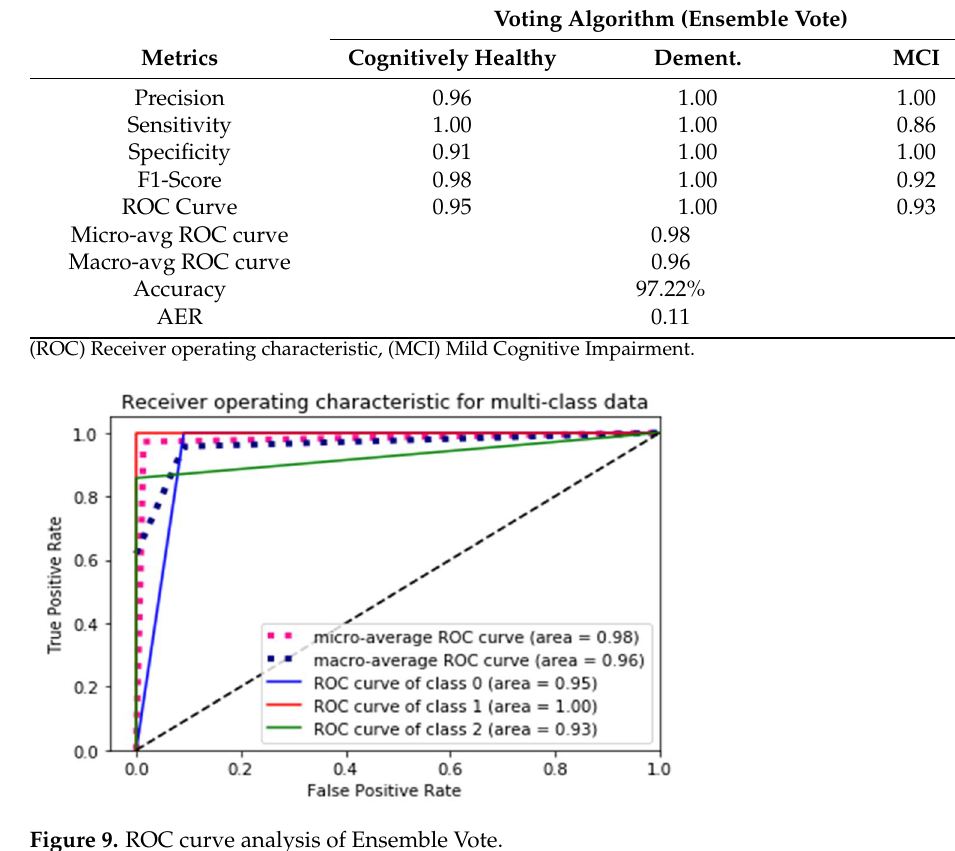
Figure 9. ROC curve analysis of Ensemble Vote.